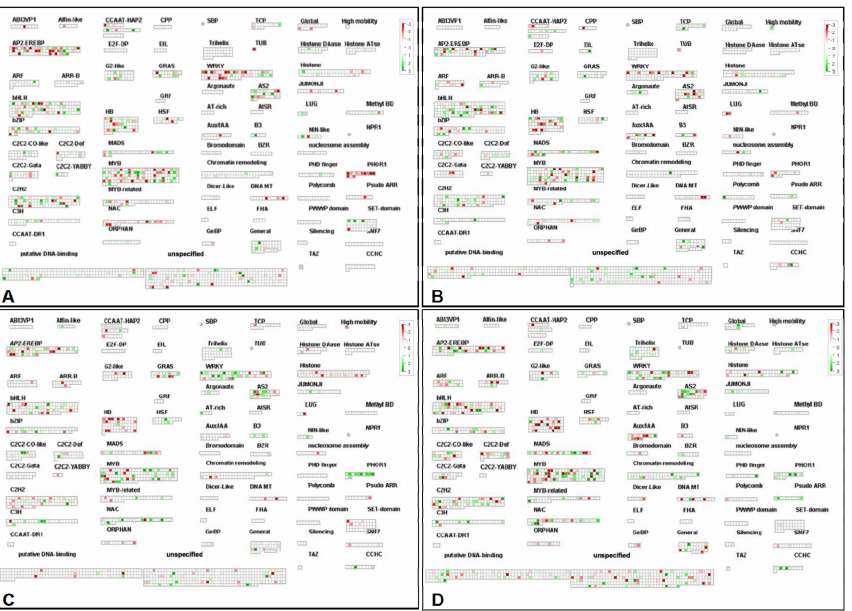
Figure 6. Relative transcription level of genes in different transcription factors. The main tran- scription factor families are listed in MapMan. Green represents upregulation, while red represents downregulation. ( A , B , C , and D ) represent the comparison group of XFSUV vs. XFSCK, XFLUV vs. XFLCK, ZCSUV vs. ZCSCK, and ZCLUV vs. ZCLCK,